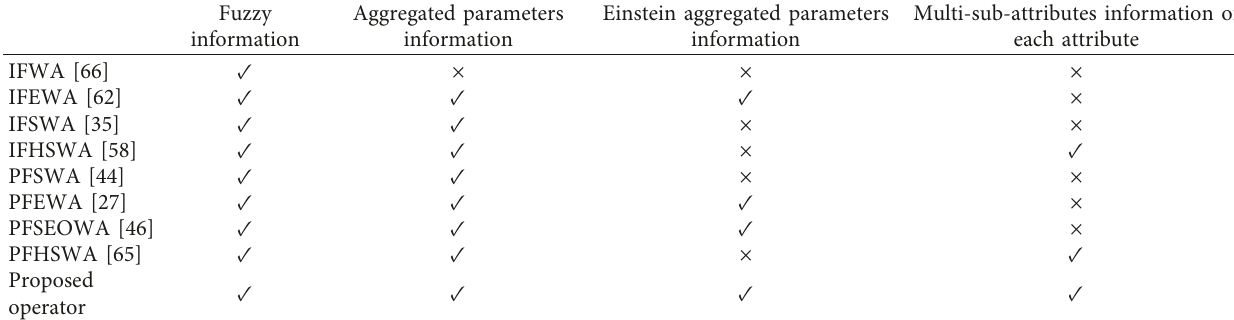
Table 6: Feature analysis of different models with a proposed model.